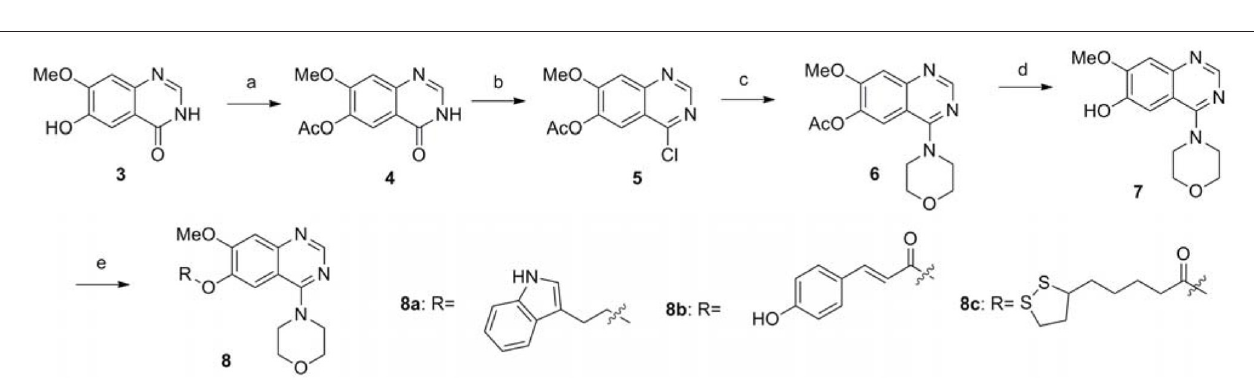
FIGURE 1 | Rational design of novel PDE10 inhibitors with antioxidant activity.